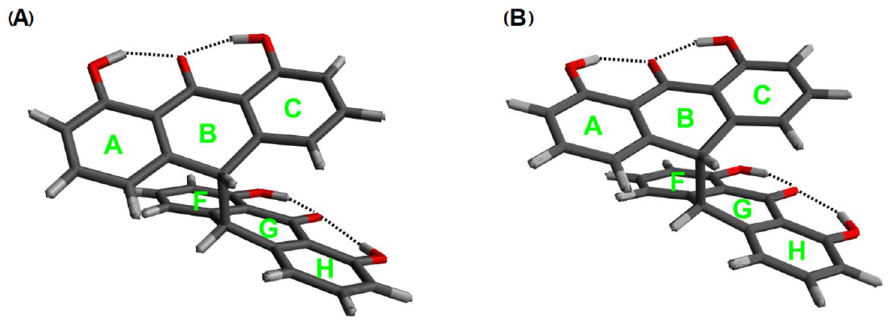
Figure 5. Comparison of the crystal ( A ) and optimized ( B ) structure of the double-anthrone moi- ety.